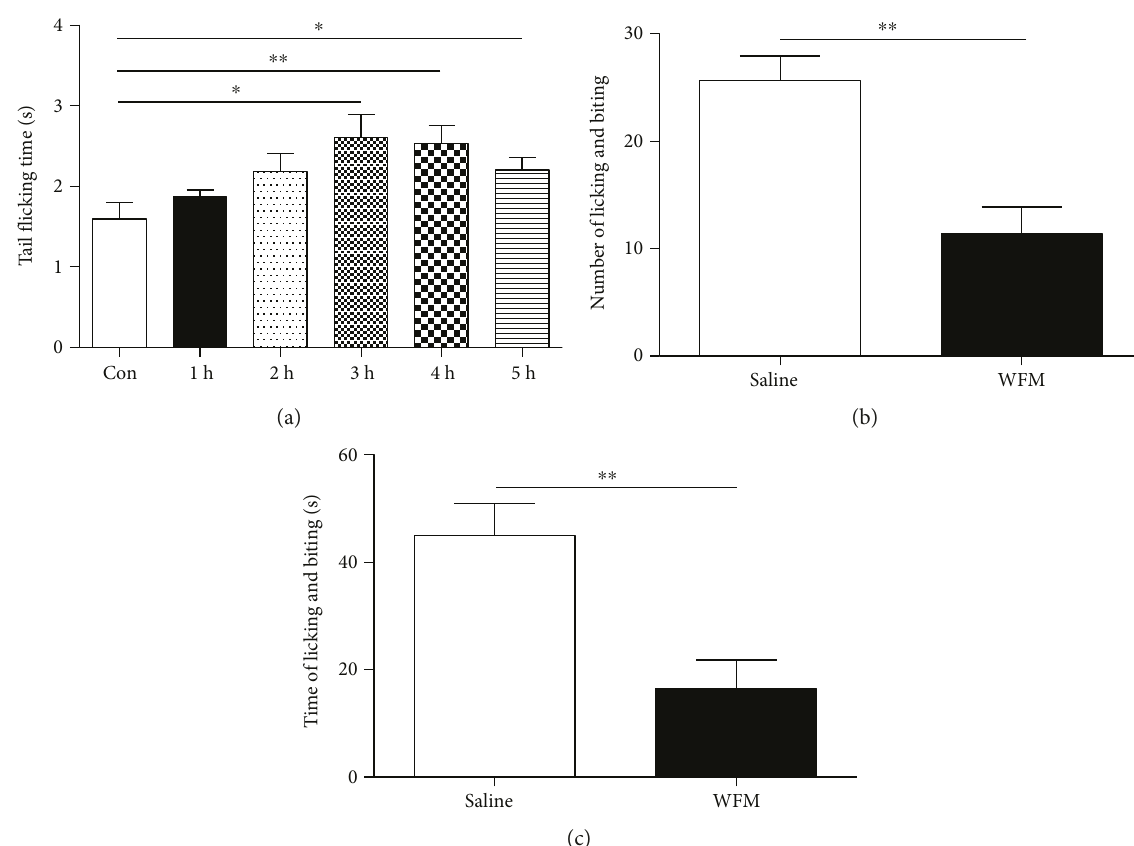
Figure 3: Antinociceptive e ff ects of WFM in the tail- fl ick and capsaicin injection assay. (a) Antinociceptive e ff ects in the tail- fl ick assay. WT mice were used in this assay. The time course of the tail- fl ick latencies was observed after WFM treatment ( n = 8 ). (b, c) E ff ects of WFM in the capsaicin assay. WT mice were used in this assay ( n = 8 ). (b) Number of licking and biting. (c) Time of licking and biting. Two-way ANOVA revealed signi fi cant drug e ff ect. ∗ p < 0 05 , ∗∗ p < 0 01 , ∗∗∗ p < 0 001